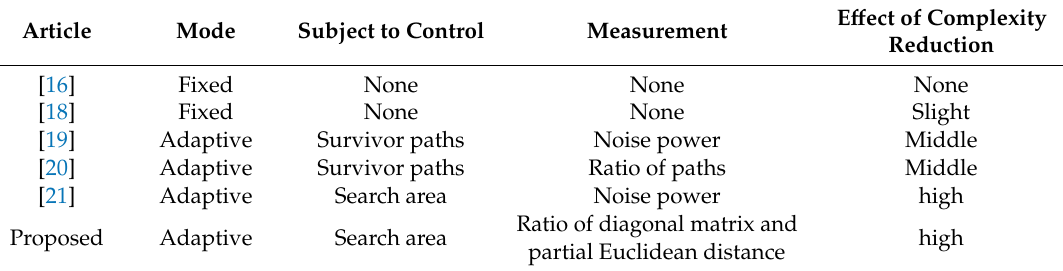
Table 1. Summary of the QRD -M